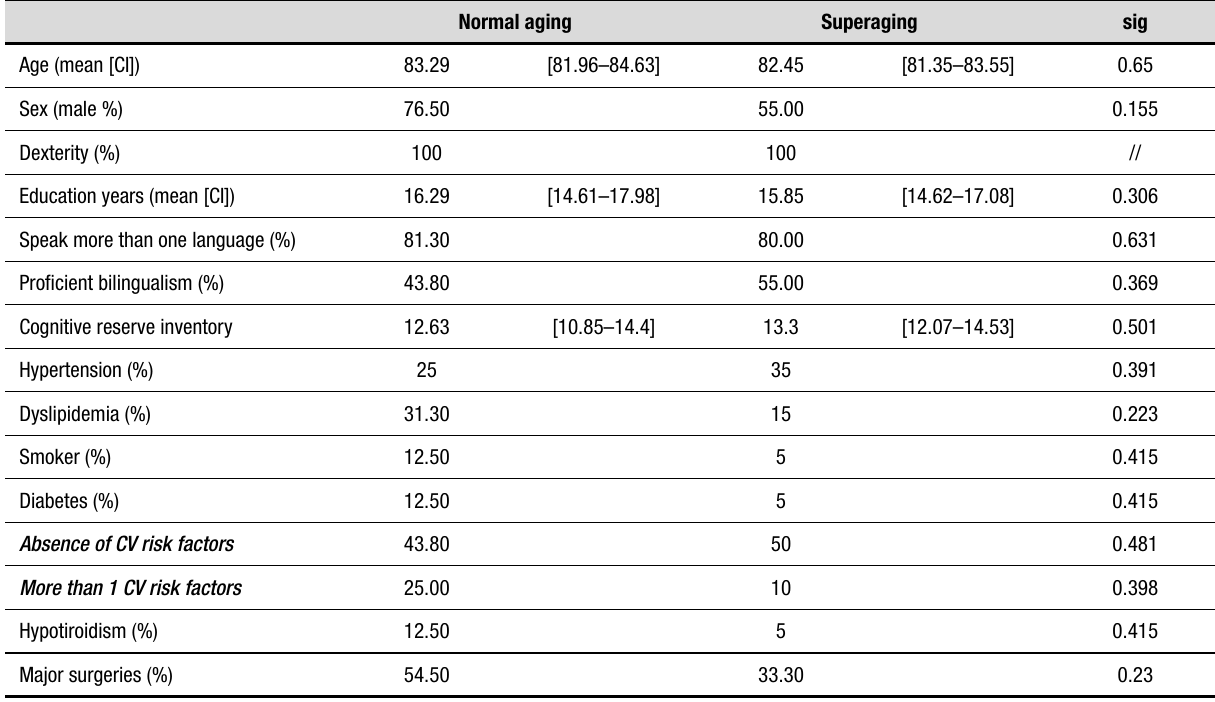
Table 1. Individual factors.